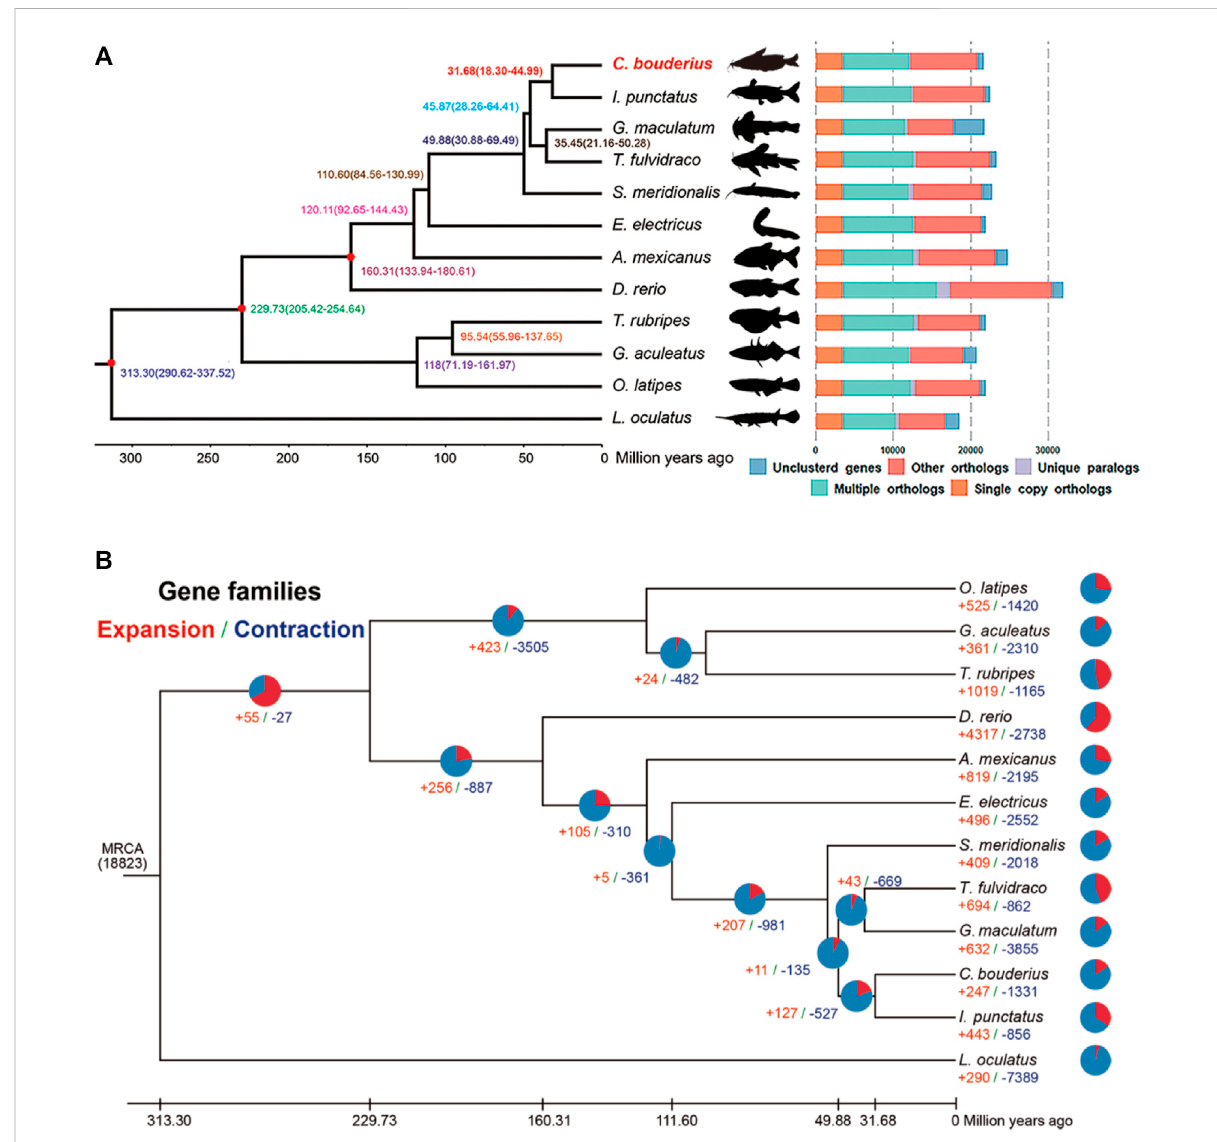
FIGURE 2 Phylogenetic and evolutionary analyses of Cranoglanis bouderius and other teleost fi shes. (A) Divergence time estimation and gene clustering in C.bouderius andother fi shspecies.Thephylogenetictreeof12specieswasconstructedusing3436single-copyorthologousgenes.Thenumbers on the branches denote estimated divergence times in millions of years ago and the three red nodes represent fossil calibration points used for divergence time estimation. (B) The expansion and contraction of gene families in 12 fi sh species genomes. The pie charts and numbers represent the proportion and speci fi c values of expanded (red) and contracted (blue) gene families, respectively. MRCA: most recent common